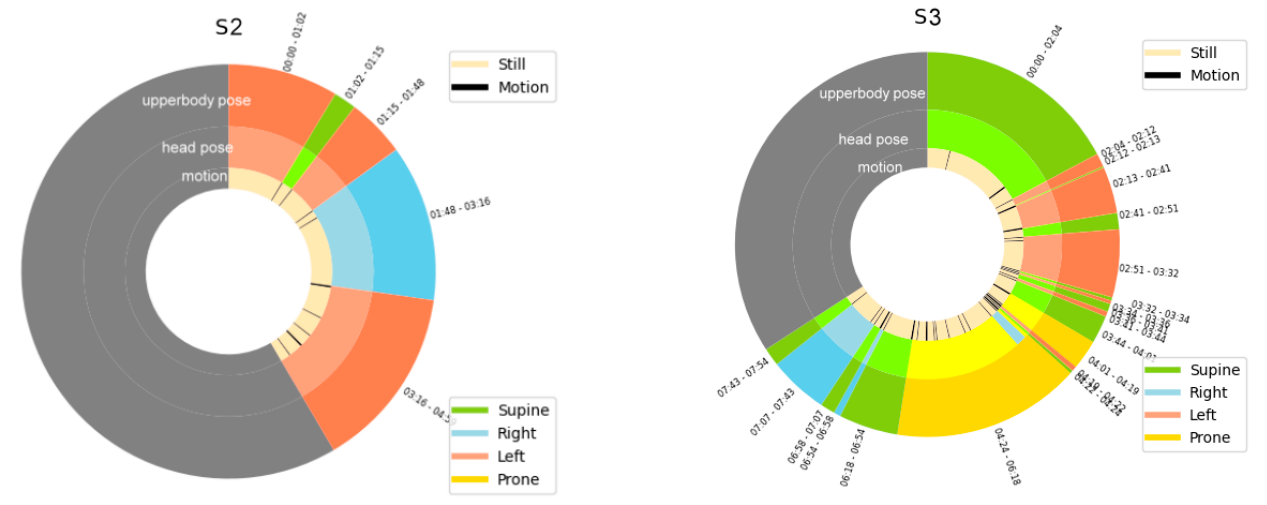
Figure 14. Pictorial representation of sleep poses and motion over time of subjects.